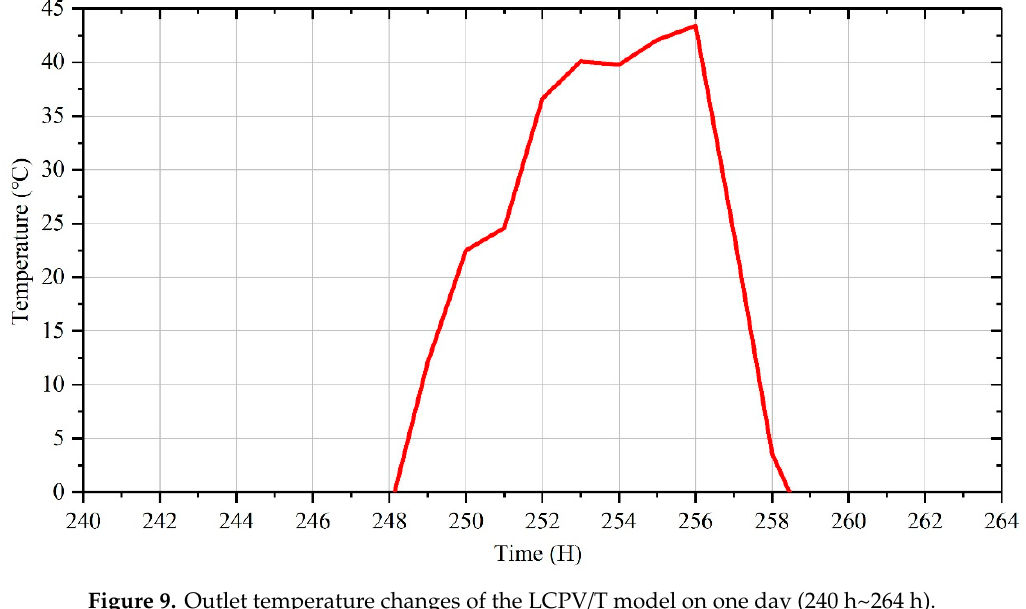
Figure 9. Outlet temperature changes of the LCPV / T model on one day (240 h~264 h).